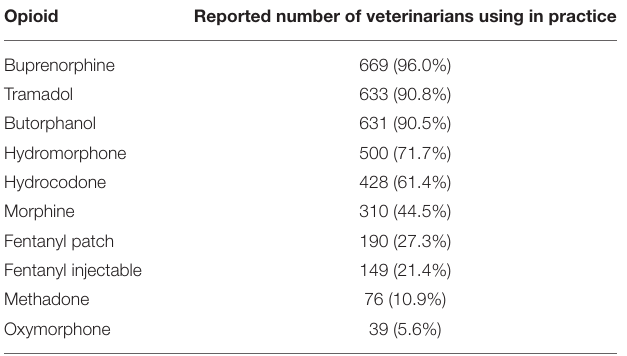
TABLE 1 | Reported usage of common opioids by 697 veterinarians. Opioid